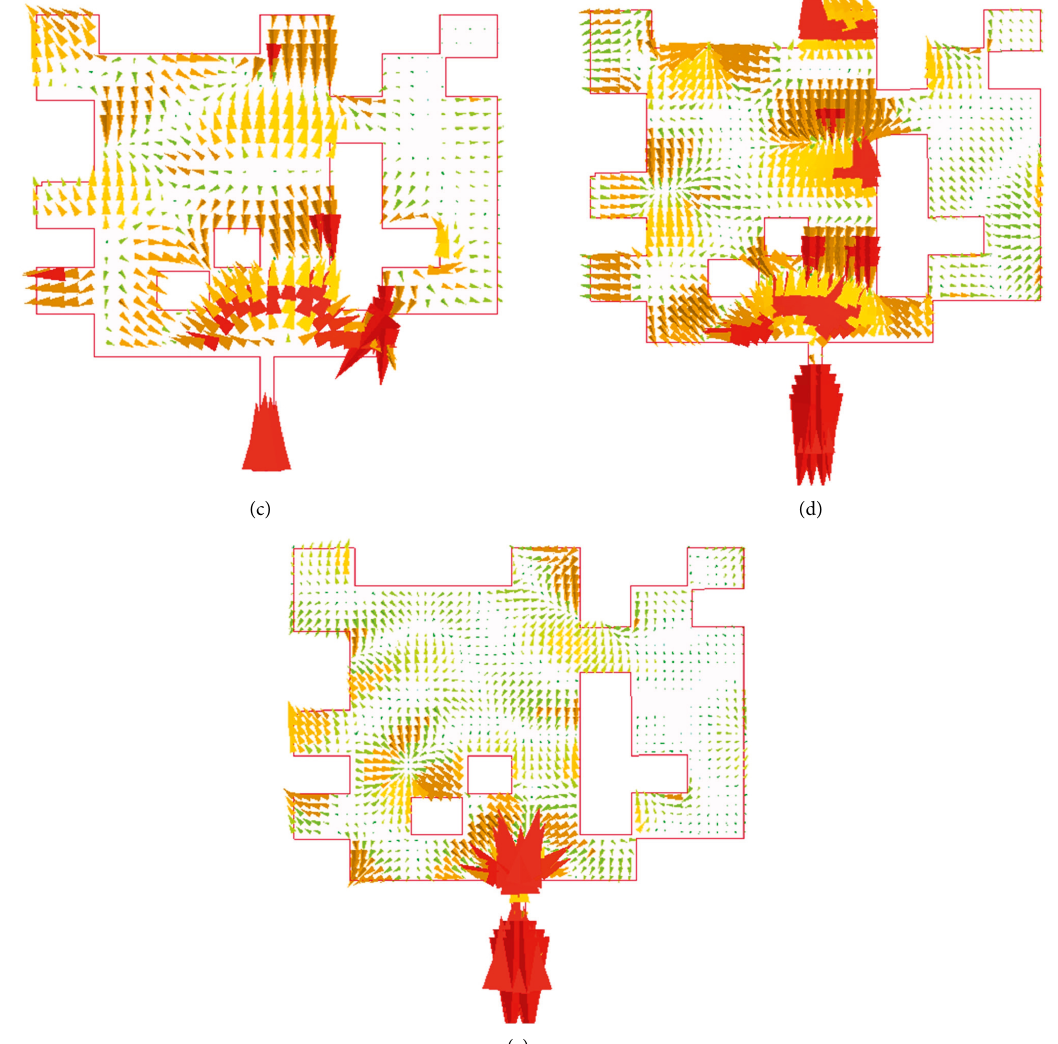
Figure 10: Current distribution on the patch surface of the optimized antenna with PTFE substrate at different resonance frequencies: (a) 27.8 GHz, (b) 30.3GHz, (c) 40.1GHz, (d) 47.1GHz, and (e) 56.7GHz.